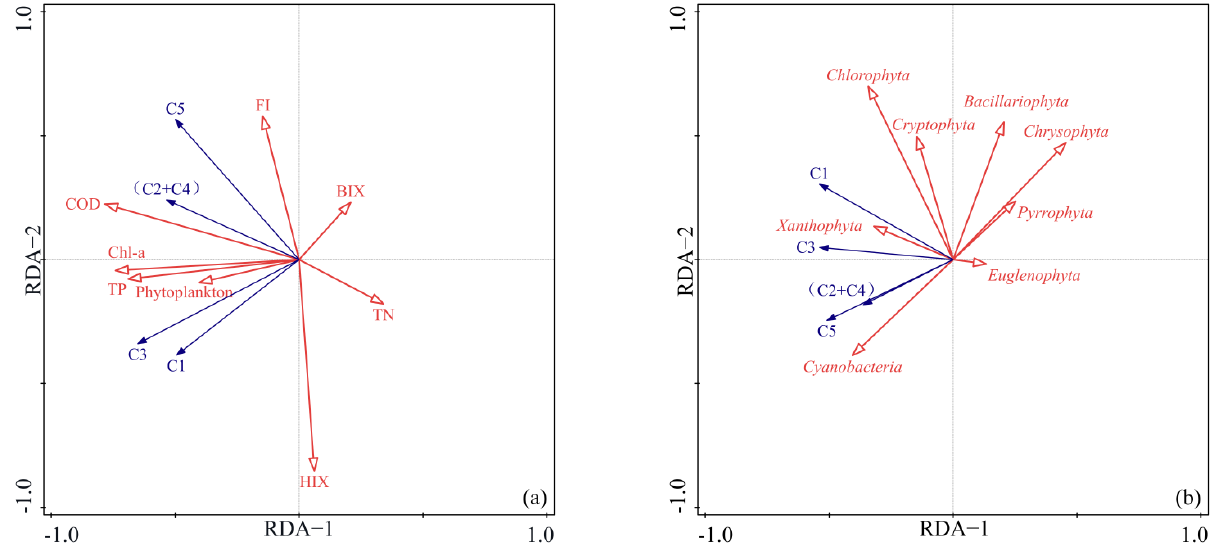
Figure 7. RDA results of DOM components, environmental factors ( a ), and phytoplankton phyla ( b ).